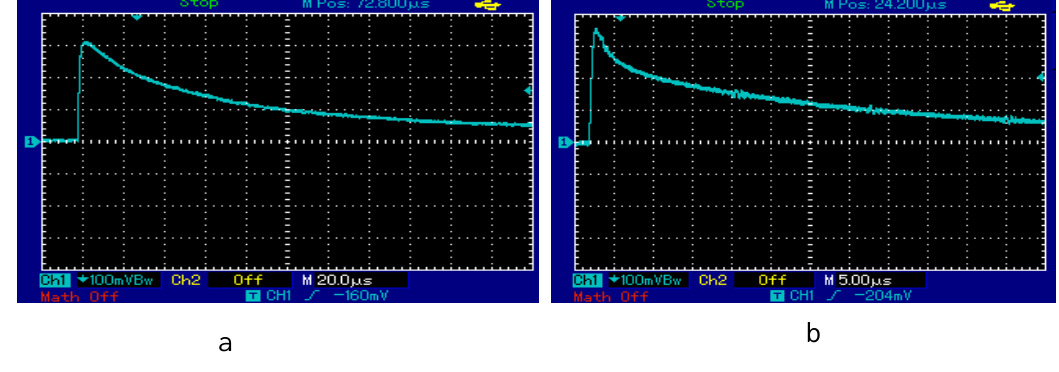
Fig.5: Received pulse .a-Smooth detector. b-engraving detector.